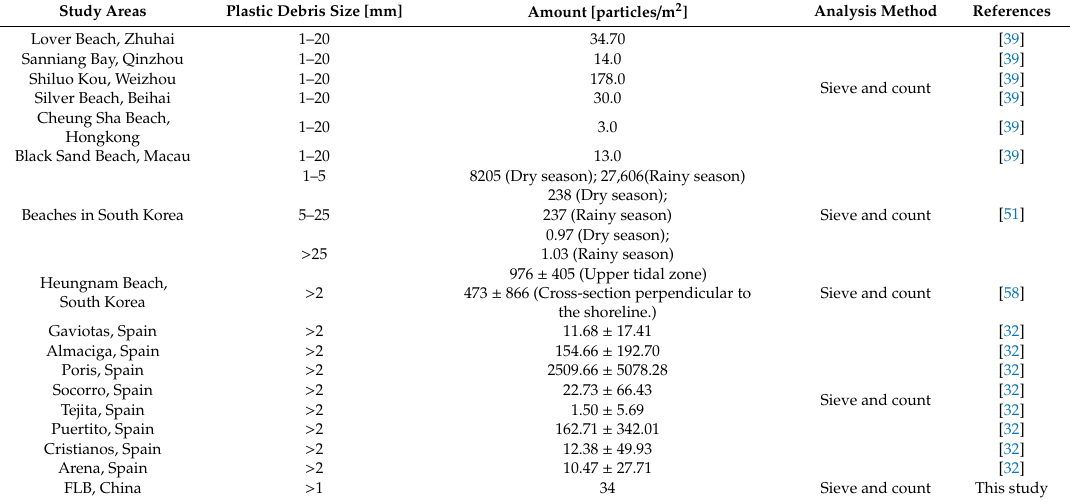
Table 3. Comparison of the amount of plastic debris with other beaches around the